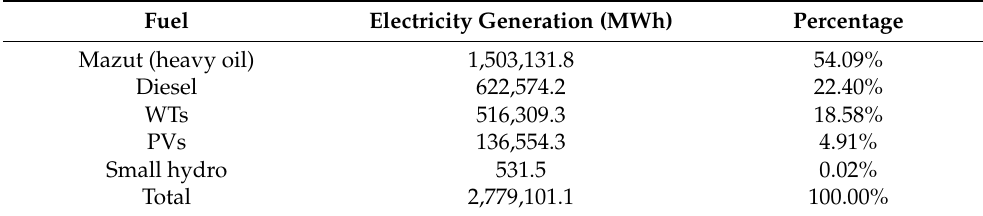
Table 4. Fuel mix for electricity generation on Crete Island (year 2020).